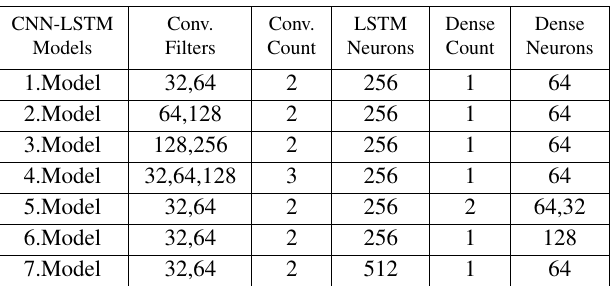
Table 5. CNN-LSTM model configuration matrix.